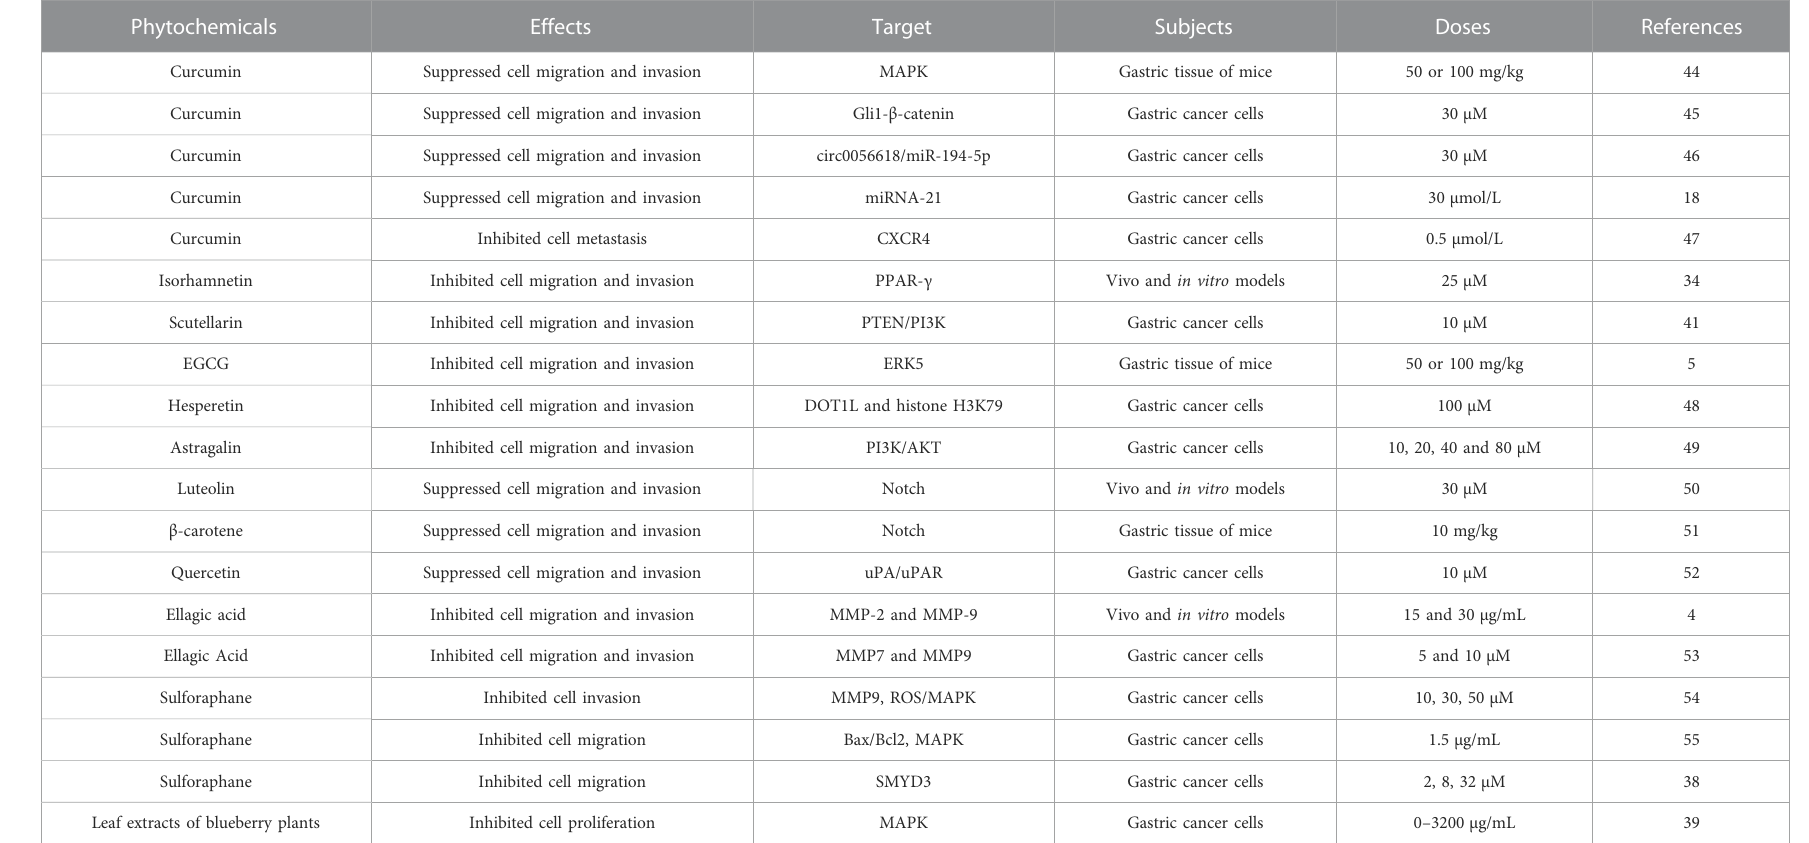
TABLE 2 Overview of the role of phytochemicals in cell migration and